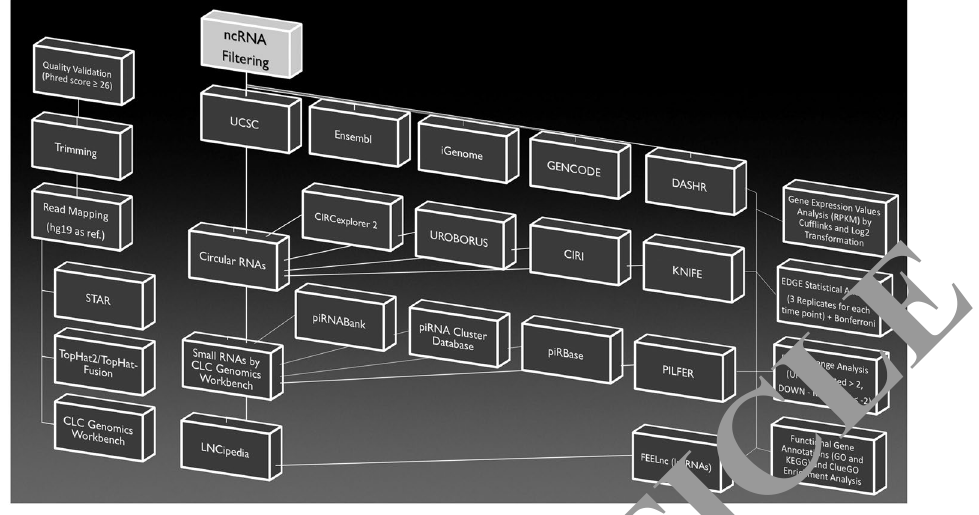
Figure 6. Graphical workflow of RNA–Seq data analyses. All data analysis followed each phase represented in the figures. In detail, on the left is illustrated the initial transcriptome quality check is illustrated on the left, following by alignment and annotation steps. Non–coding RNA filtering and analytic pipelines, specific for circular RNAs, PIWI–interacting RNAs and long non–coding RNAs, can be found in the central block. The differential expression analysis, followed by pathway enrichment, is represented on the right